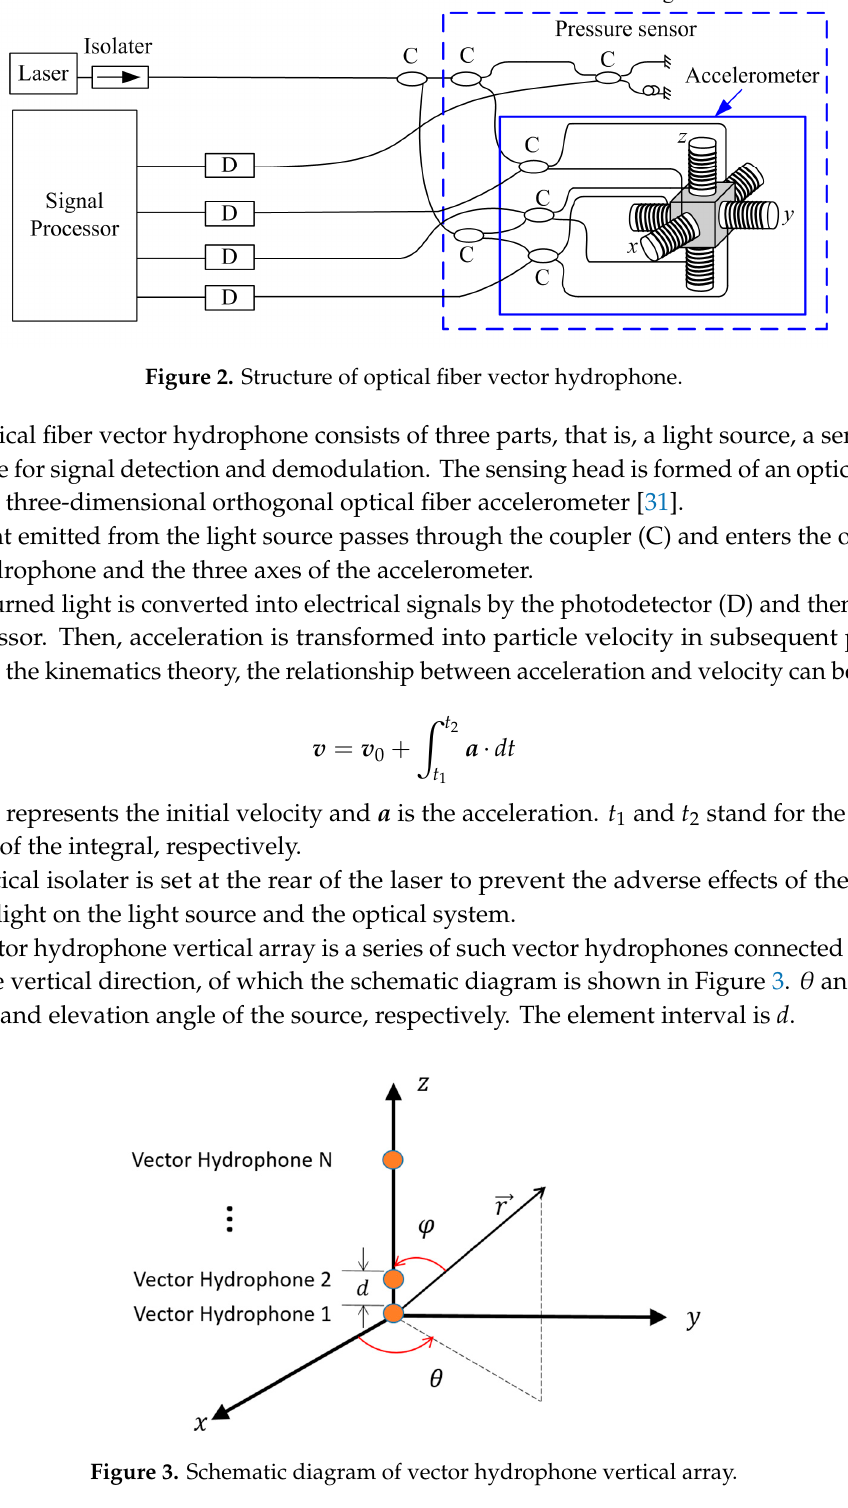
Figure 3. Schematic diagram of vector hydrophone vertical array.